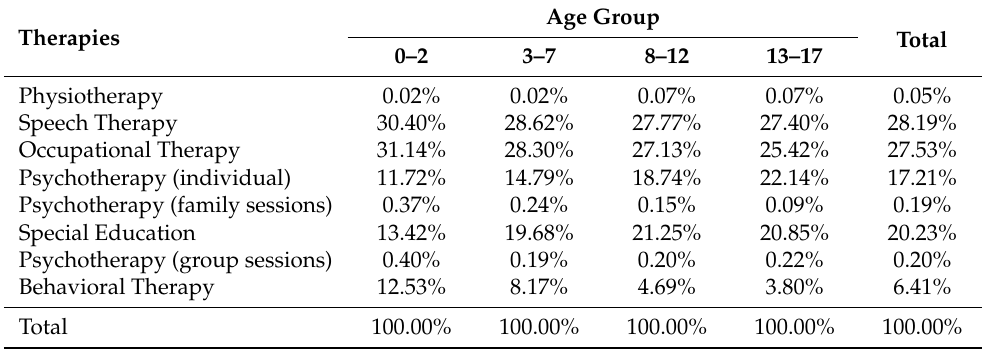
Table 8. Non-medication interventions for ASD per